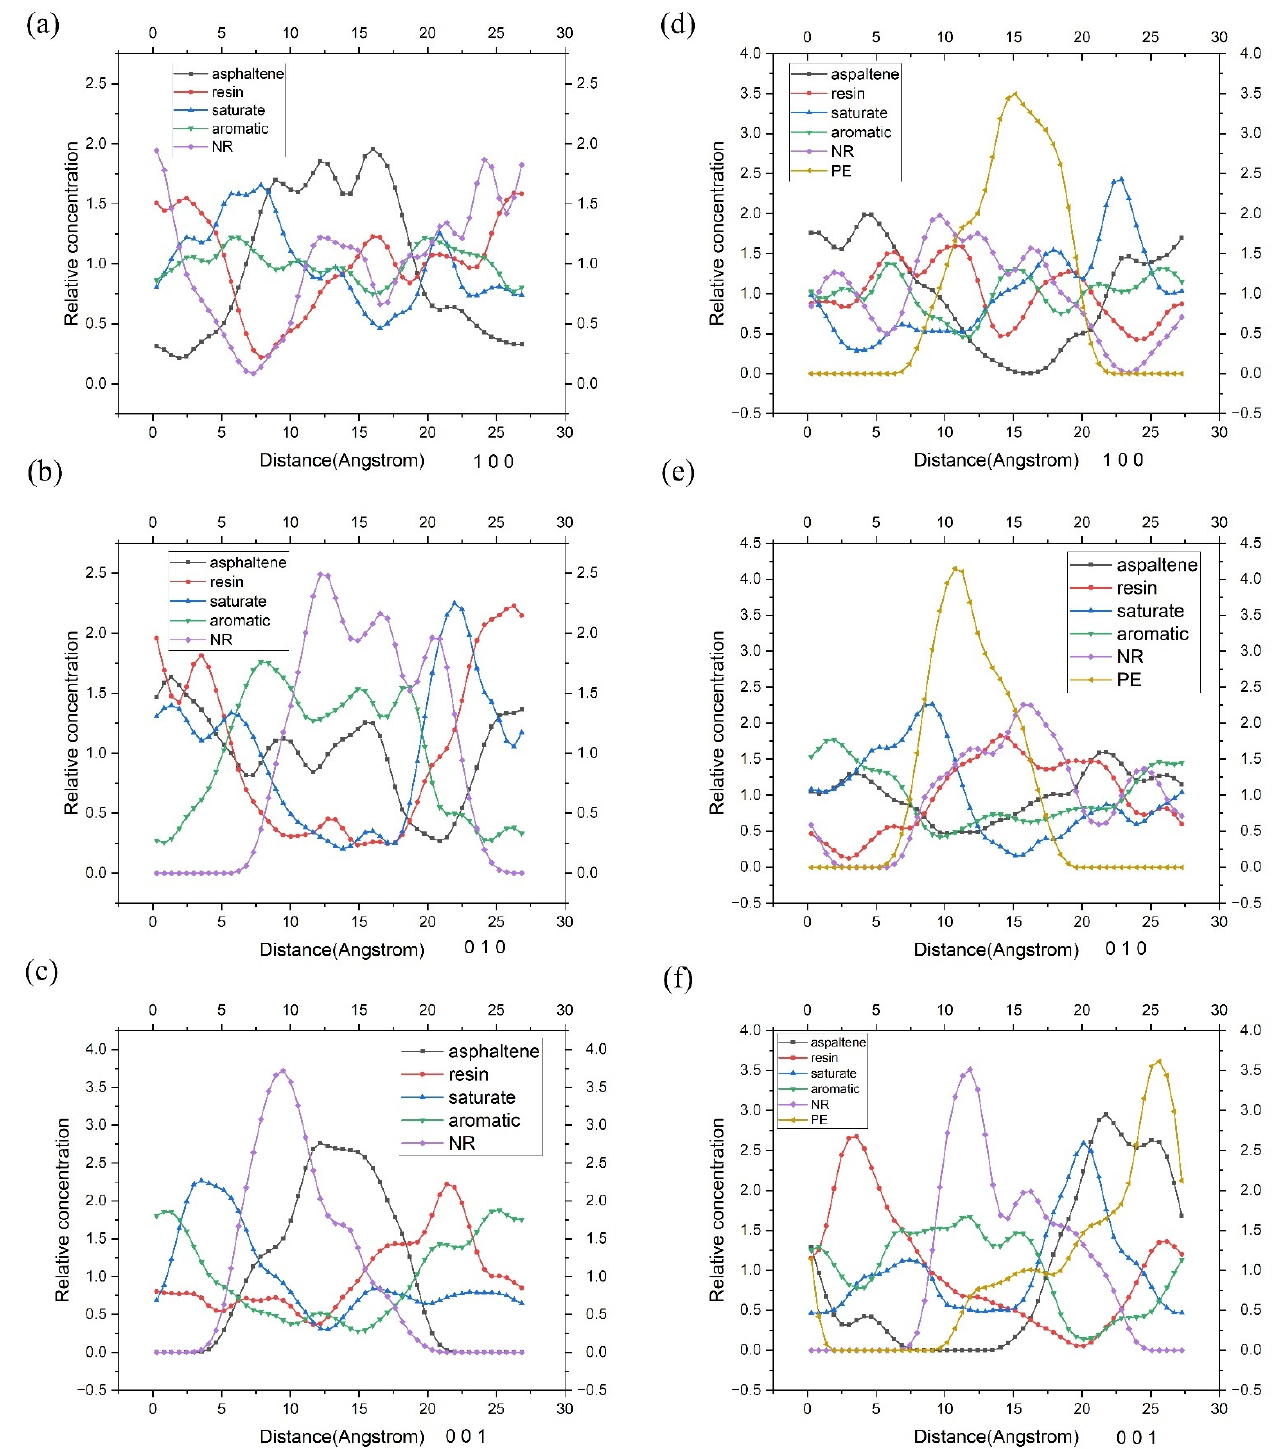
Figure 10. Concentration distribution of each component for NR-modified asphalt and PE/NR- modified asphalt. (The relative concentration of NR-modified asphalt in different directions, including ( a ) 1 0 0, ( b ) 0 1 0, and ( c ) 0 0 1; The relative concentration of PE/NR-modified asphalt in different directions includes ( d ) 1 0 0, ( e ) 0 1 0, and ( f ) 0 0